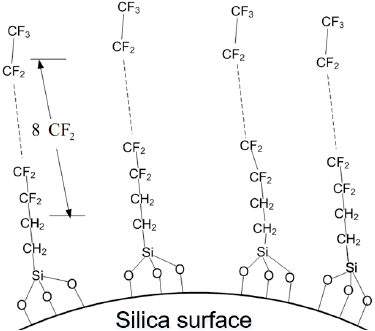
Figure 1. Schematic diagram of the surface modification of nanosilica with FAS-17 (1H,1H,2H,2H- perfluorodecyltrimethoxysilane).